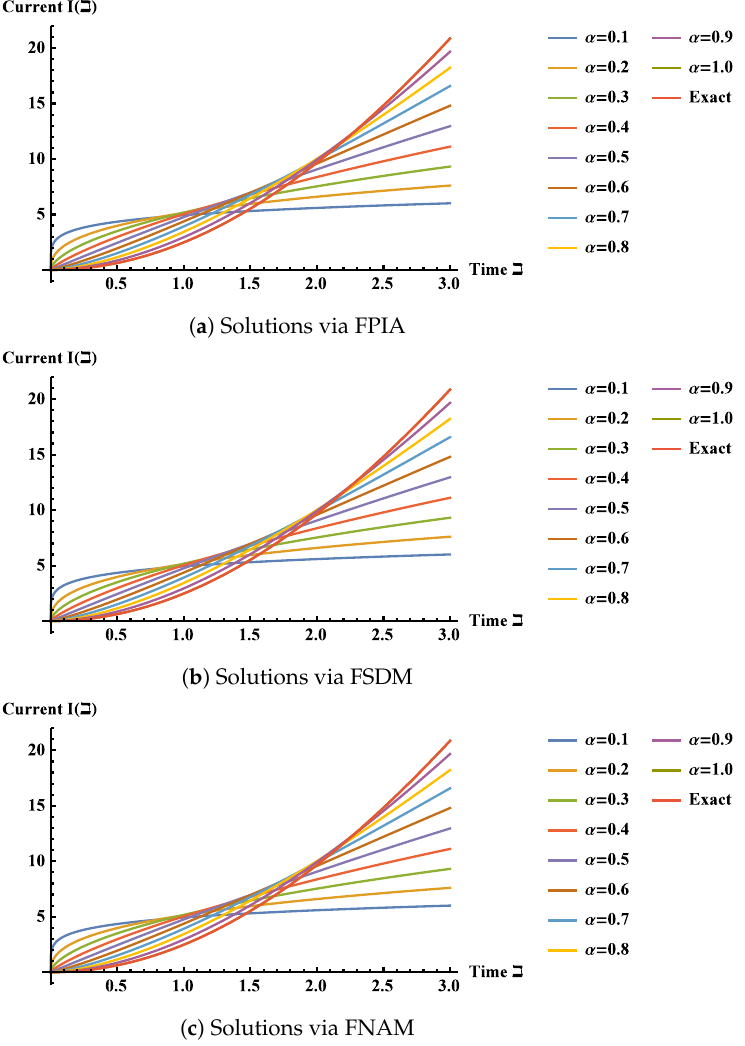
Figure 3. Numerical solutions obtained by ( a ) FPIA, ( b ) FSDM, and ( c ) FNAM of the electrical inductor–capacitor circuit equation of fractional-order at different α